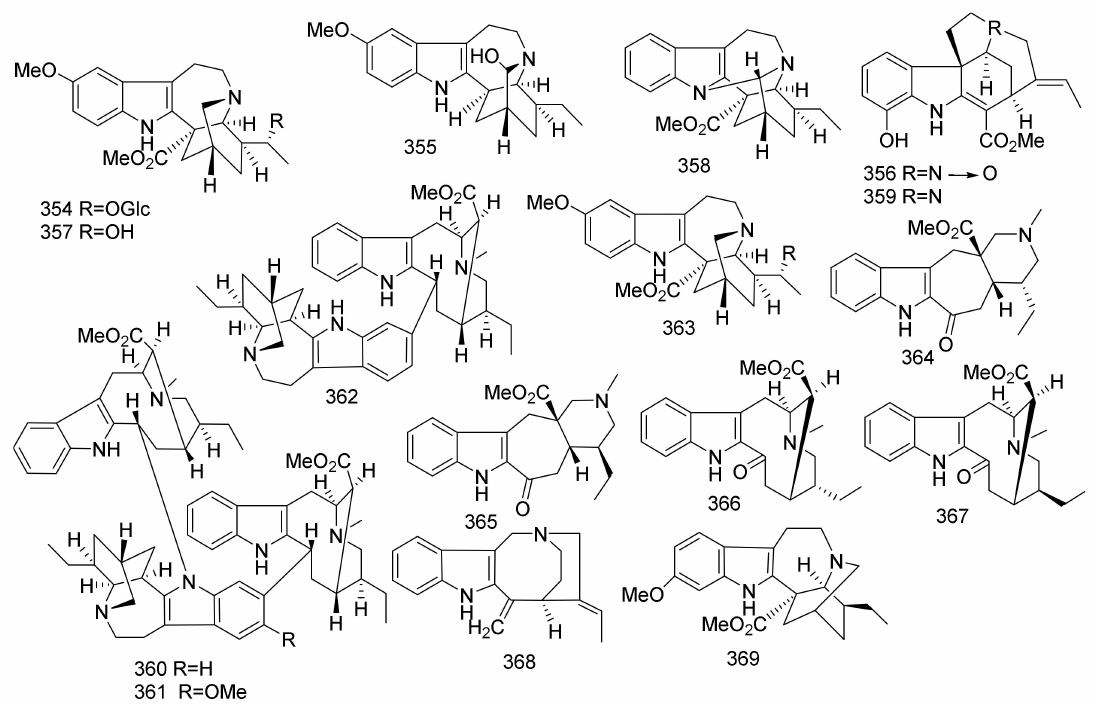
Figure 28. Compounds 354 – 369